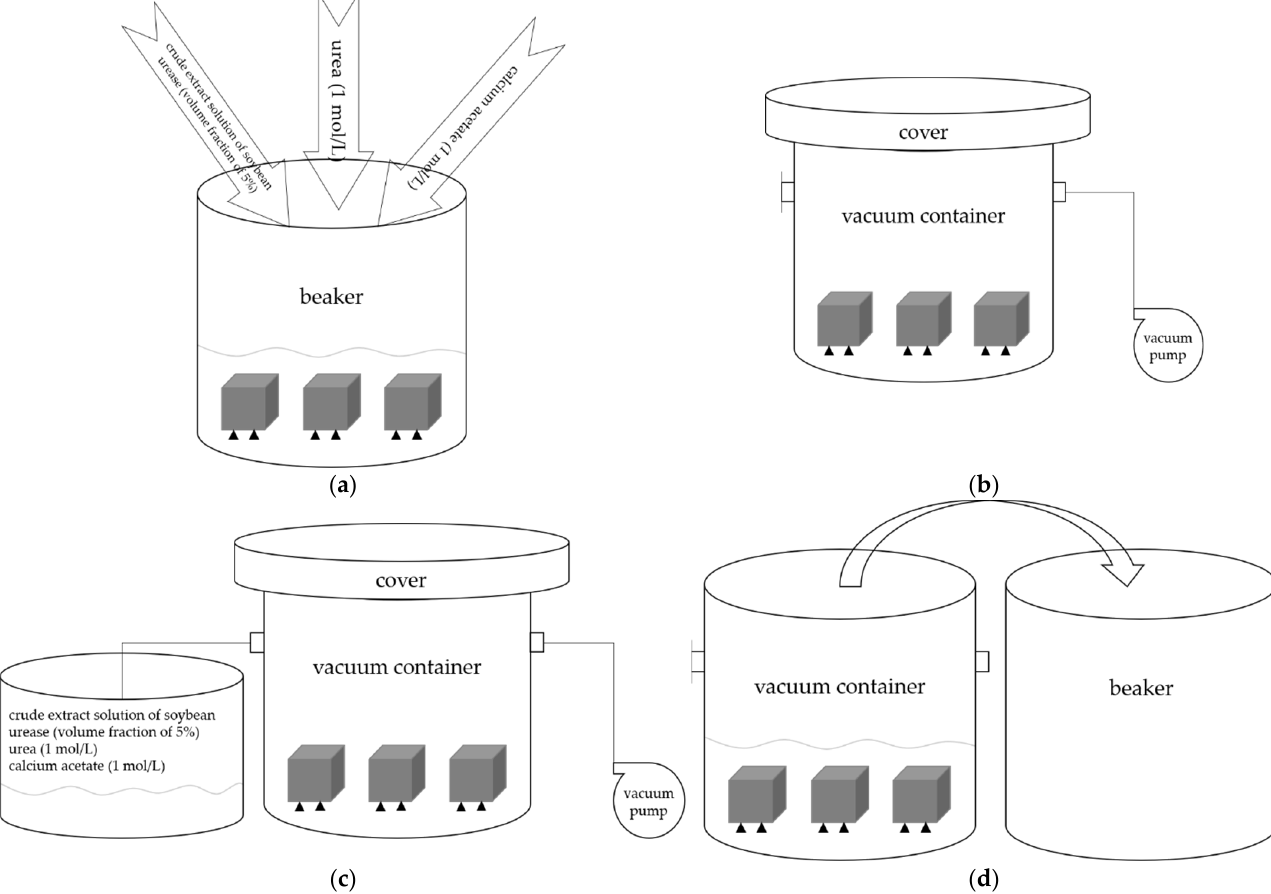
Figure 5. ( a ) The process of immersion method. ( b – d ) The process of negative pressure method.